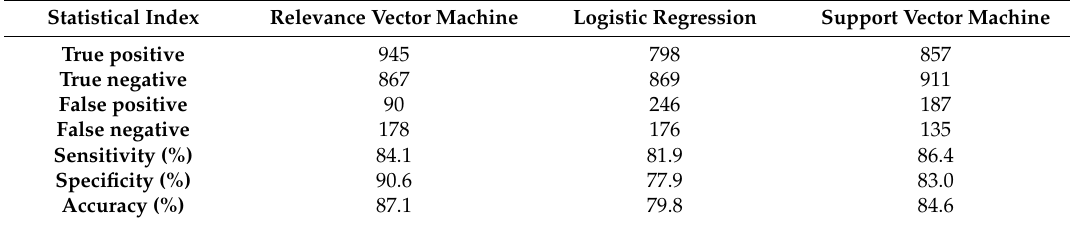
Table 4. Model validation using the validation